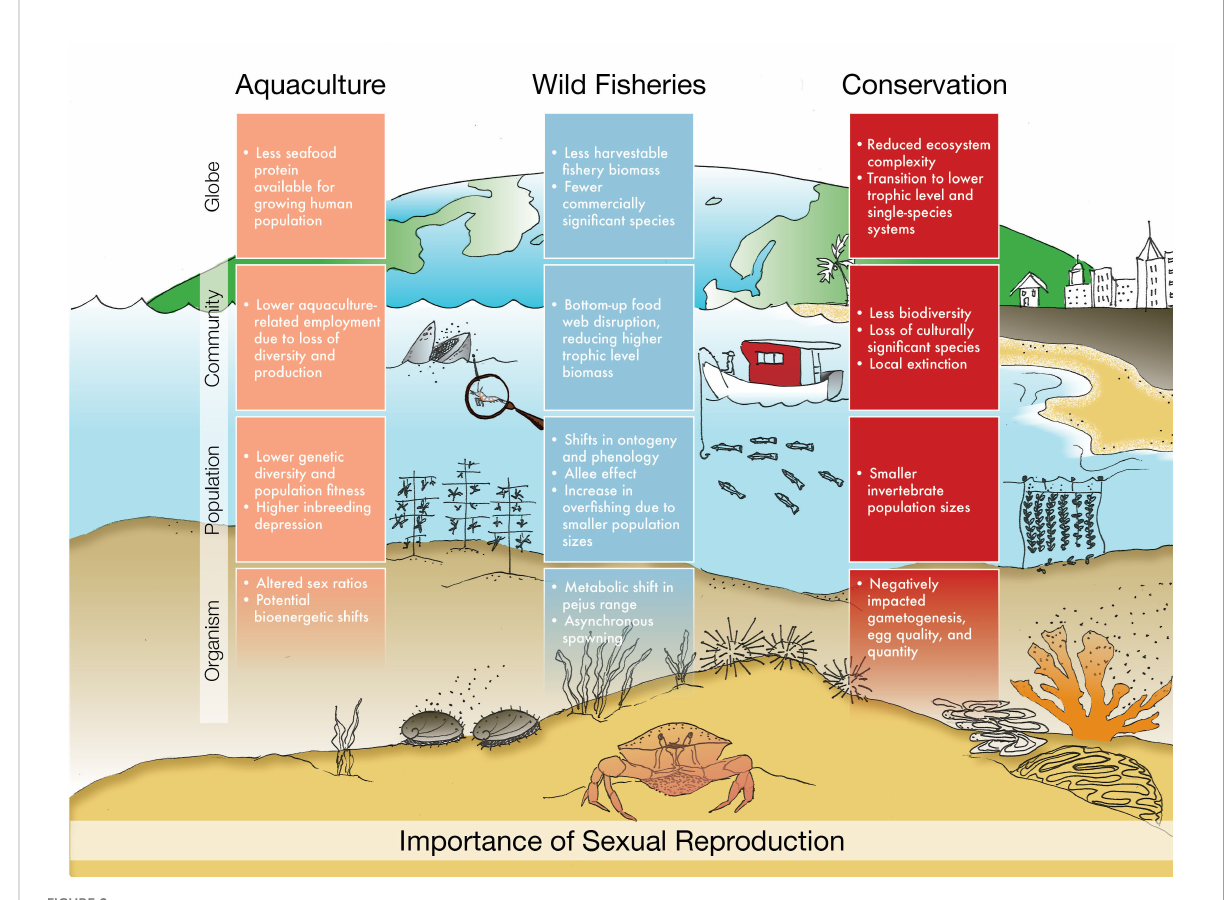
FIGURE 2 Potential effects of OA-caused changes in reproductive processes at the organism, population, community, and global level for commercial and restoration aquaculture, wild fi sheries, and conservation and restoration of wild populations. Implications mentioned are not necessarily exclusive to one